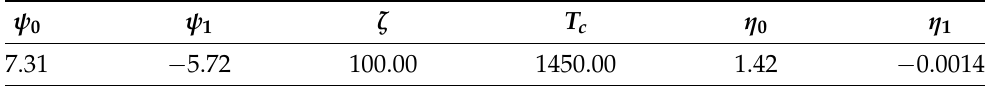
Table 5. Saturation shear resistance and initial hardening